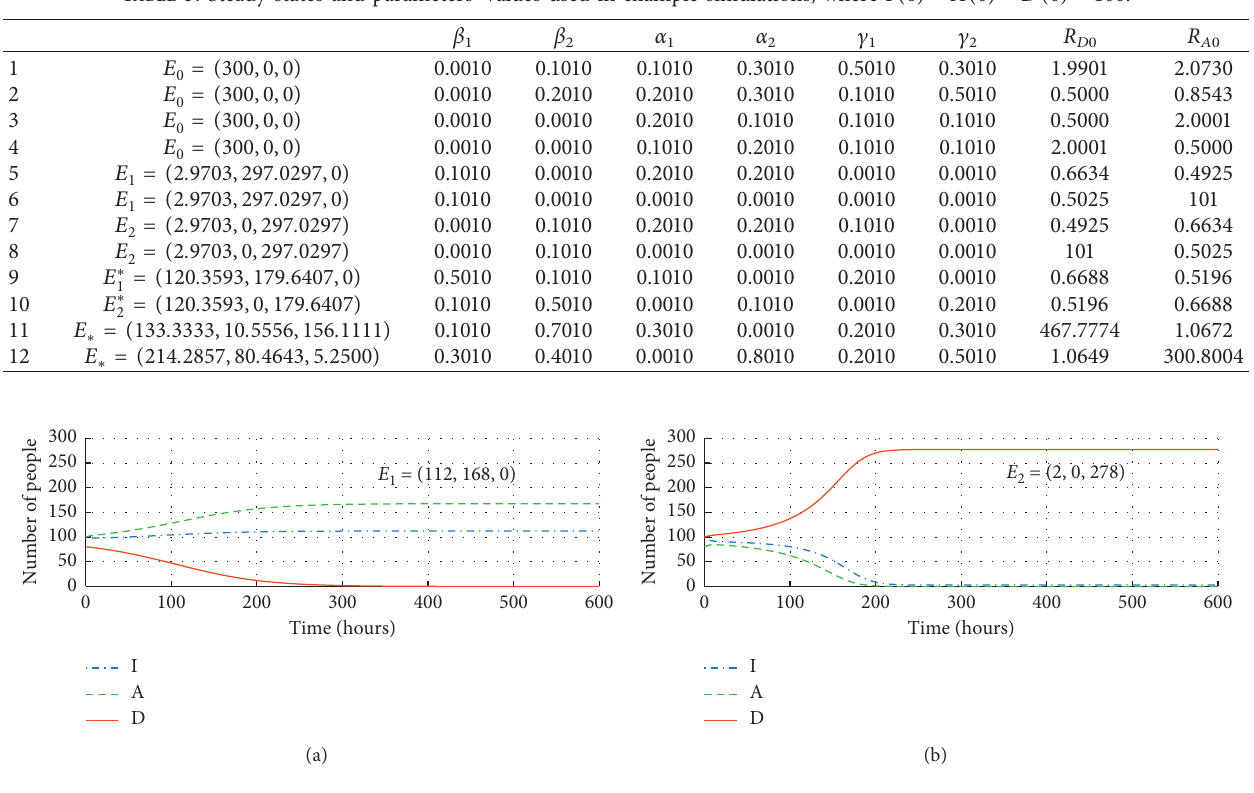
Figure 2: Illustration of the bistability of E 1 and E 2 at the same time using the set of parameters of example 9 from Table 3. Stability of E 1 (a) when I ( 0 ) � 100 , A ( 0 ) � 100, and D ( 0 ) � 80. Stability of E 2 (b) when I ( 0 ) � 100 , A ( 0 ) � 80, and D ( 0 ) �